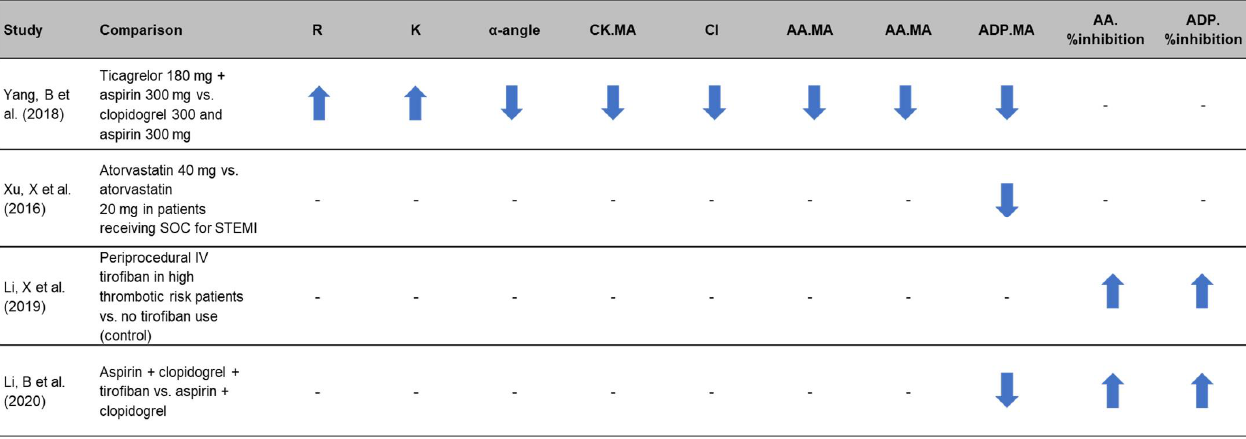
Figure 3. Thromboelastography parameters are impacted by therapy escalation, reflecting greater platelet inhibition [35–38]. Arrows reflect increase (up) or decrease (down) in the parameters. AA: arachidonic acid; ADP: adenosine diphosphate; CK: citrated kaolin; CI: coagulation index; K: kinetics; MA: maximum amplitude; R: reaction time; SOC: standard of care; STEMI: ST-segment elevation myocardial infarction.